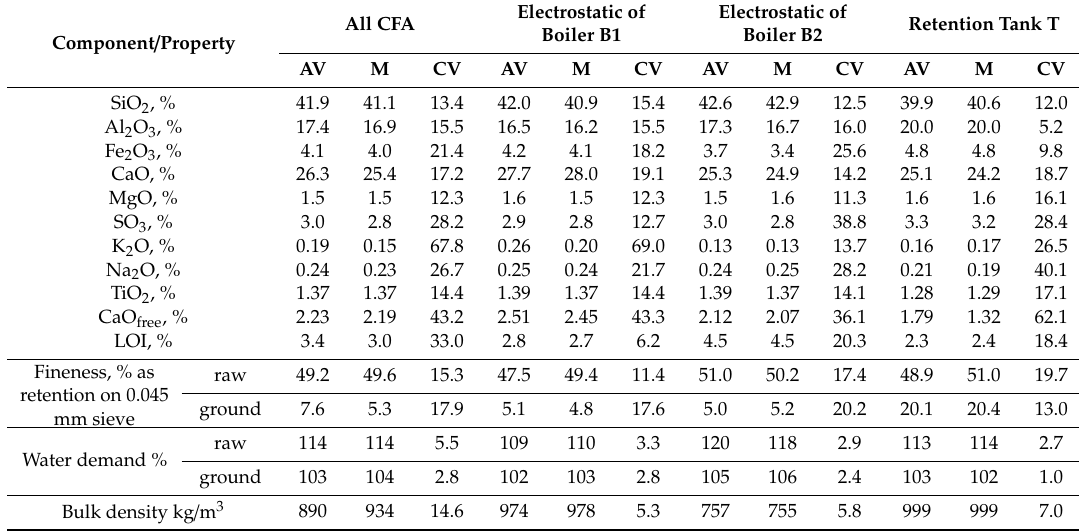
Table 1. Variability of composition and properties of raw calcareous fly ash (CFA), AV—average value, M—median, CV—coe ffi cient of variation.